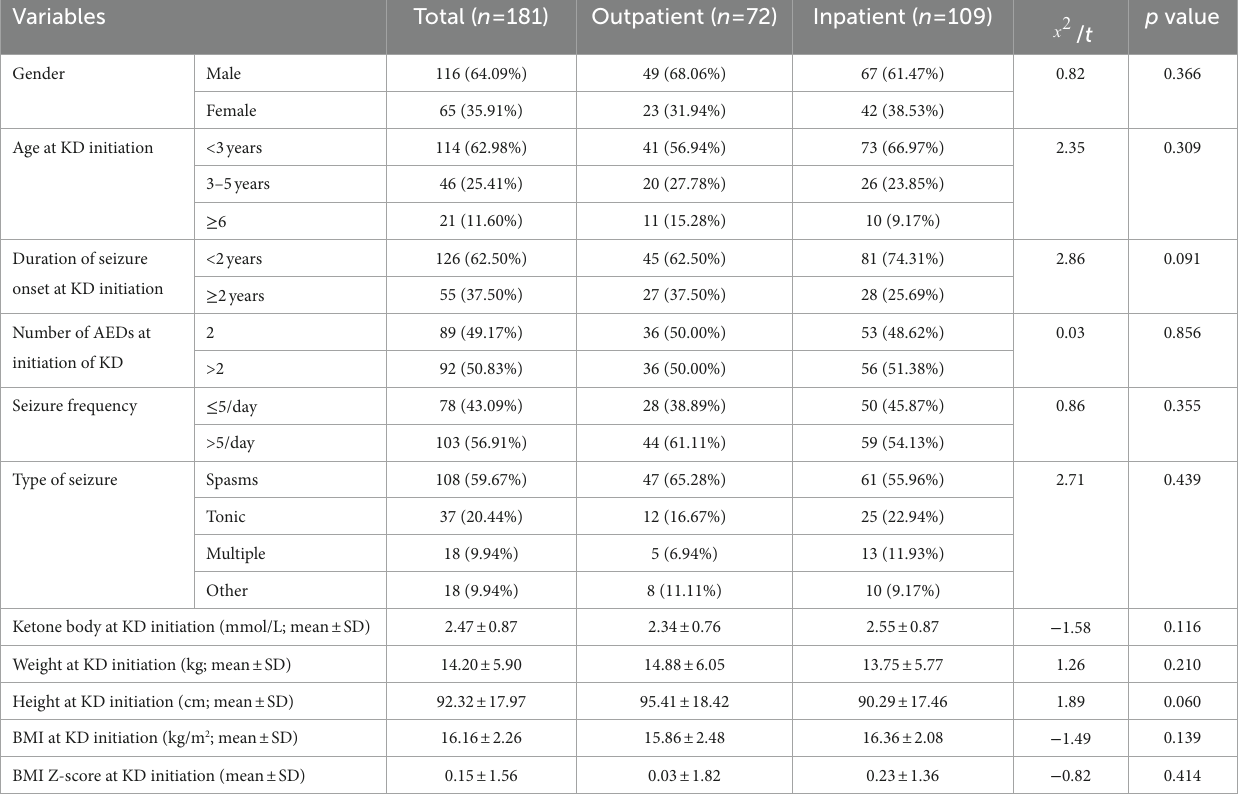
TABLE 1 Demographics and clinical characteristics at